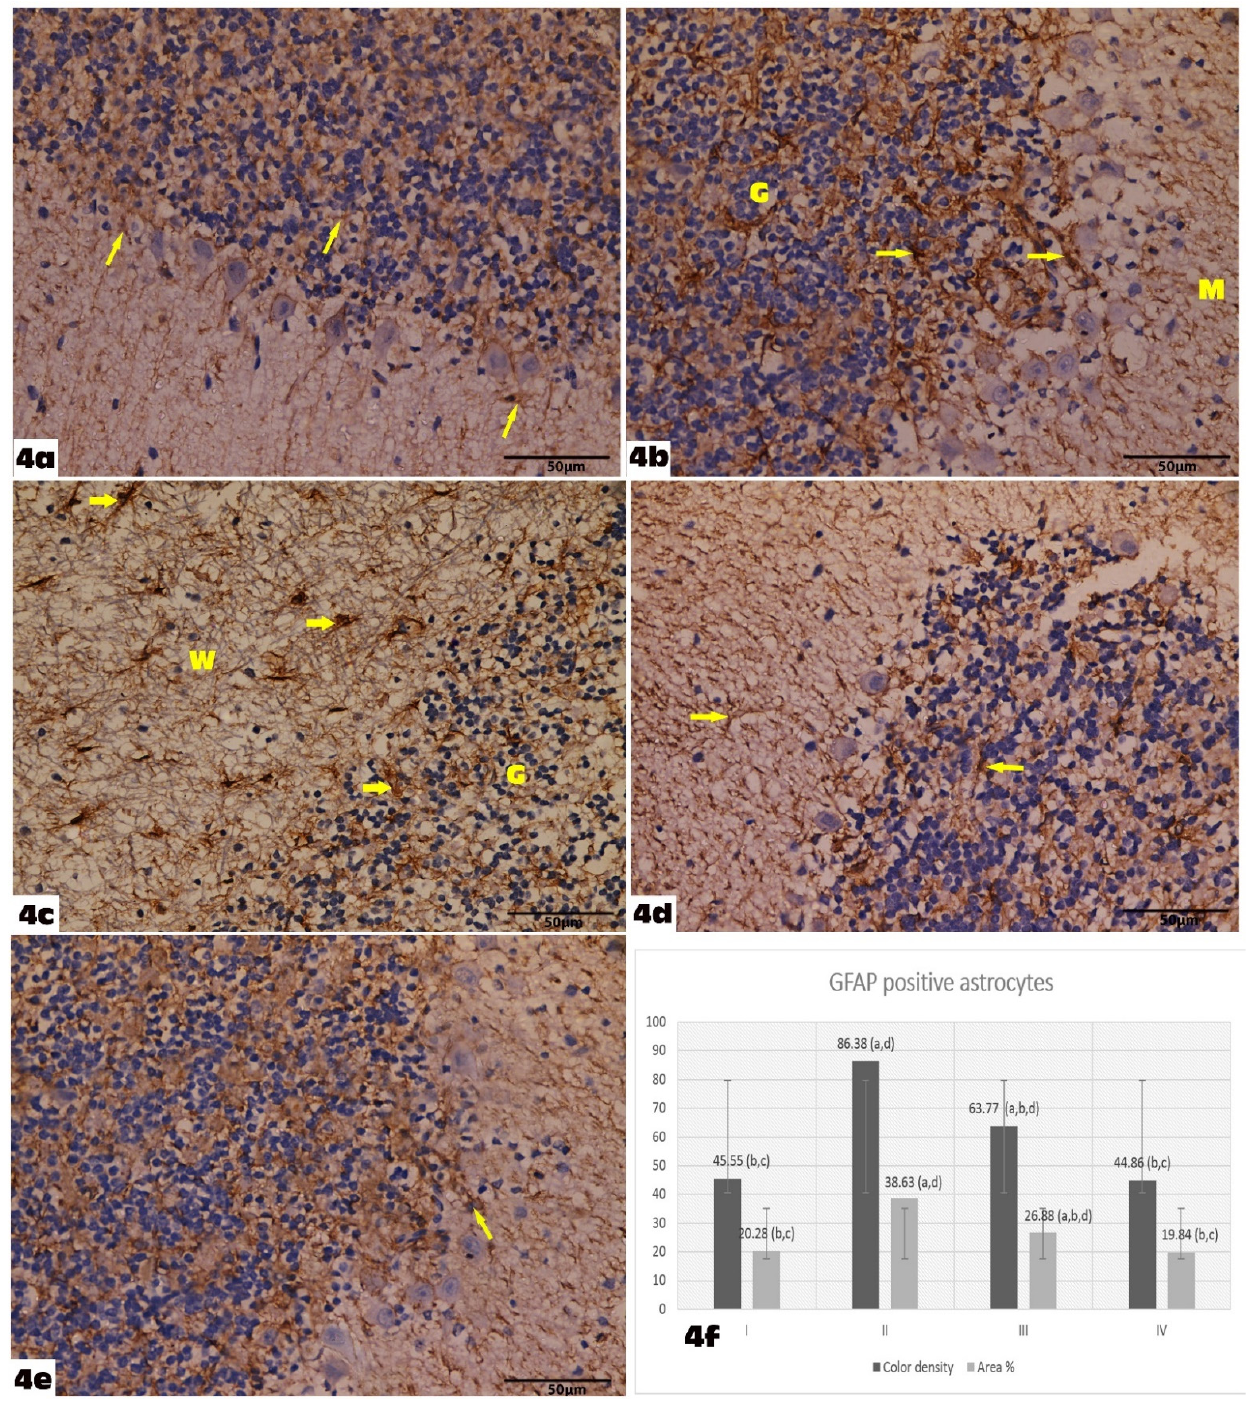
Figure 4. Shows Glial fibrillary acidic protein (GFAP) immunohistochemically stained cerebellar sections: (GFAP immunostain X 400). ( a ): Control group showing scattered GFAP immunoreactive cells with long and thin processes (arrows) in the different cerebellar cortical layers. ( b , c ): Group II showing more abundant GFAP-positive cells in all cerebellar layers molecular (M), Purkinje (P), Granular (G), and in the medullary white matter (M). These cells appear larger with relatively longer and thicker processes (arrows) as compared with the control group. ( d ): Group III showing positive expression of GFAP, which is apparently increased as compared to that noticed in the control rats, but lesser than group II (arrows). ( e ): Group IV showing scattered GFAP immunoreactive cells (arrow) in the different cerebellar cortical layers with the same features as in the control group. ( f ):